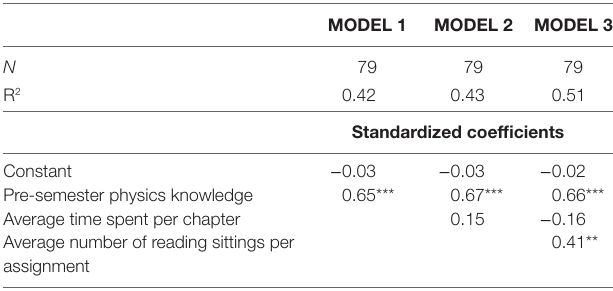
FigUre 13 | Histogram of average number of annotations entered by students per assignment on Perusall.